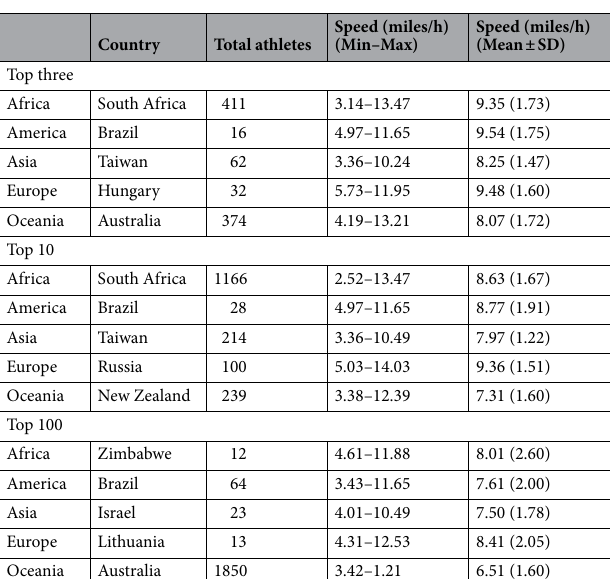
Figure 3 presents the linear regression results for performance across time considering athletes from the best countries in the top three, top 10, and top 100, respectively. For women, runners from Russia, Hungary, and Finland were the fastest, while runners from Brazil, Russia, and Lithuania were the fastest among men. The time frame considered was the last 10 years (from 2010), in which a significant performance decline was shown for women from Sweden ( r 2 = 0.10; p < 0.001; 95%CI = − 0.18– − 0.08). Based on the r 2 values, the magnitude of the performance decline was about 0.10miles/h across the years. For men, performance decline was showed for Brazilian ( r 2 = 0.27; p < 0.001; 95%CI = − 0.47 – − 0.18) and Russian runners ( r 2 = 0.02; p = 0.017; 95%CI = − 0.18 – − 0.018), in which a decline of 0.27 miles/h and 0.02 miles/h was showed across the years, respectively. Athletes